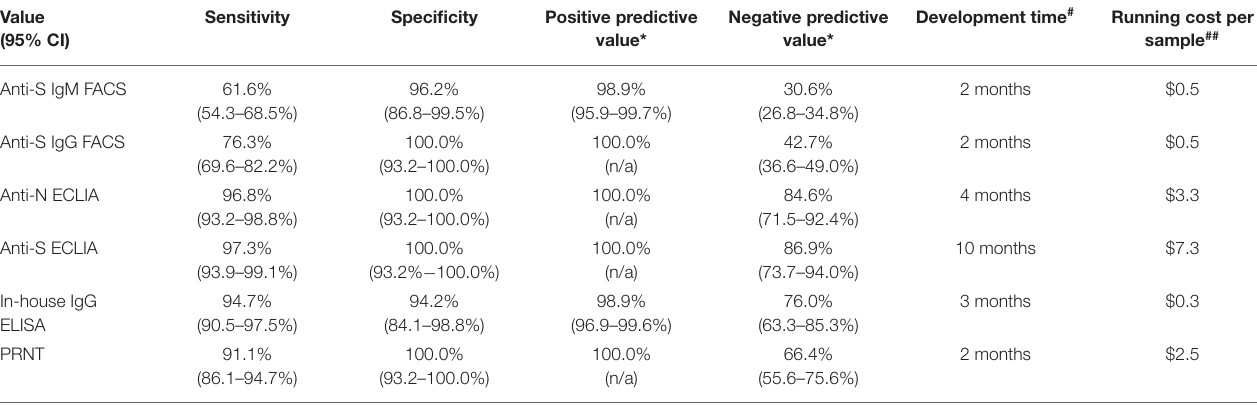
TABLE 3 | Evaluation of the serological